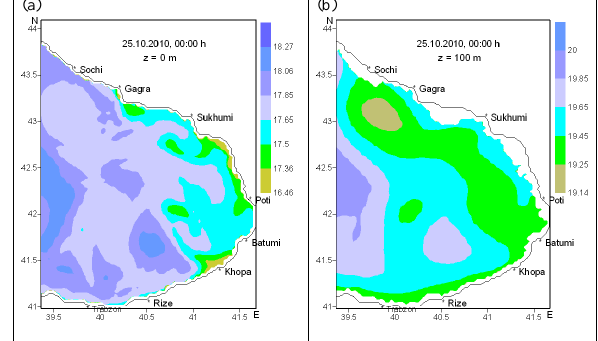
Fig. 12. Temperature field (deg. C) at 25.10.2010, 00:00 h on depths of 0 m (a) and 100 m (b).